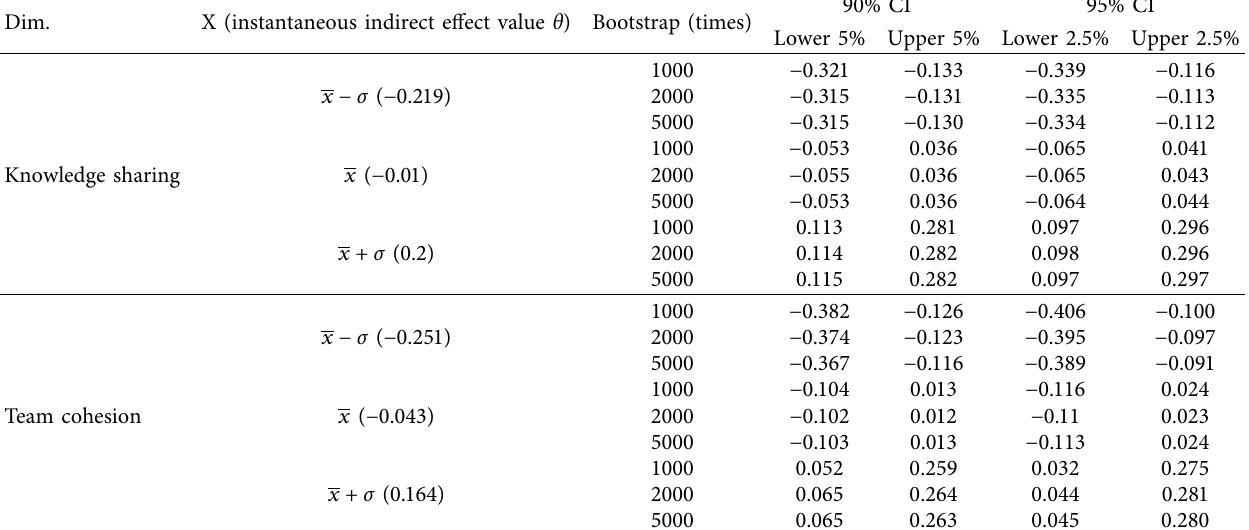
Table 8: Test of the instantaneous indirect